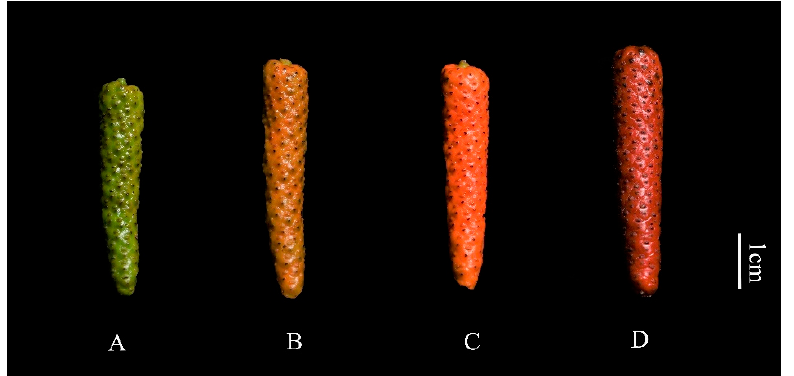
Figure 1. Physical phenotypes of the four developmental stages of cabya. Note: The ( A ) phase is the green ripening phase; the ( B ) phase is the color-breaking phase; the ( C ) phase is the orange phase; the ( D ) phase is the red ripening phase.